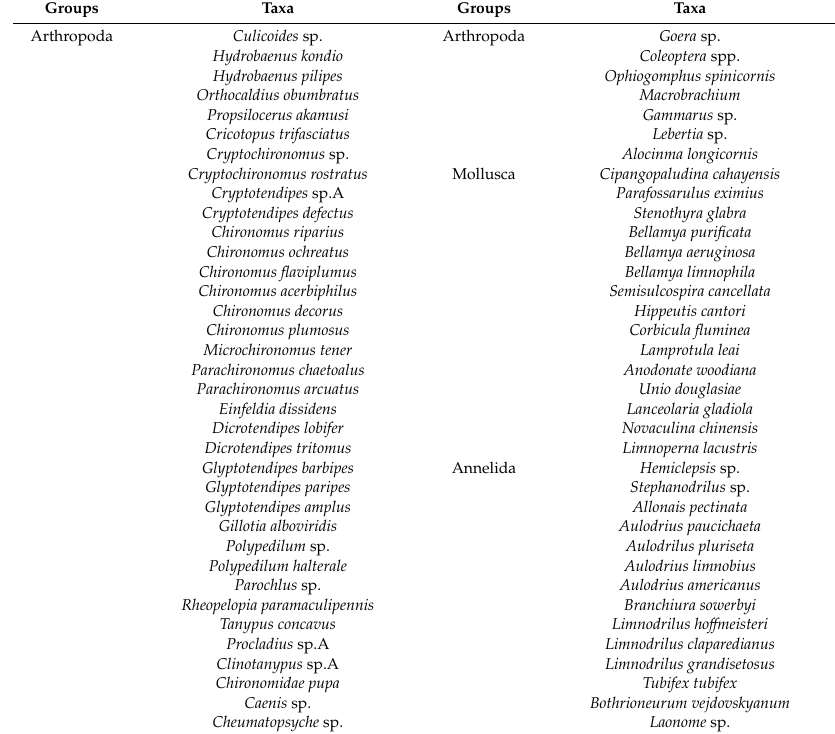
Di ff erent letters indicate significant di ff erences. Table A2. The list of Macroinvertebrates in the Weishan